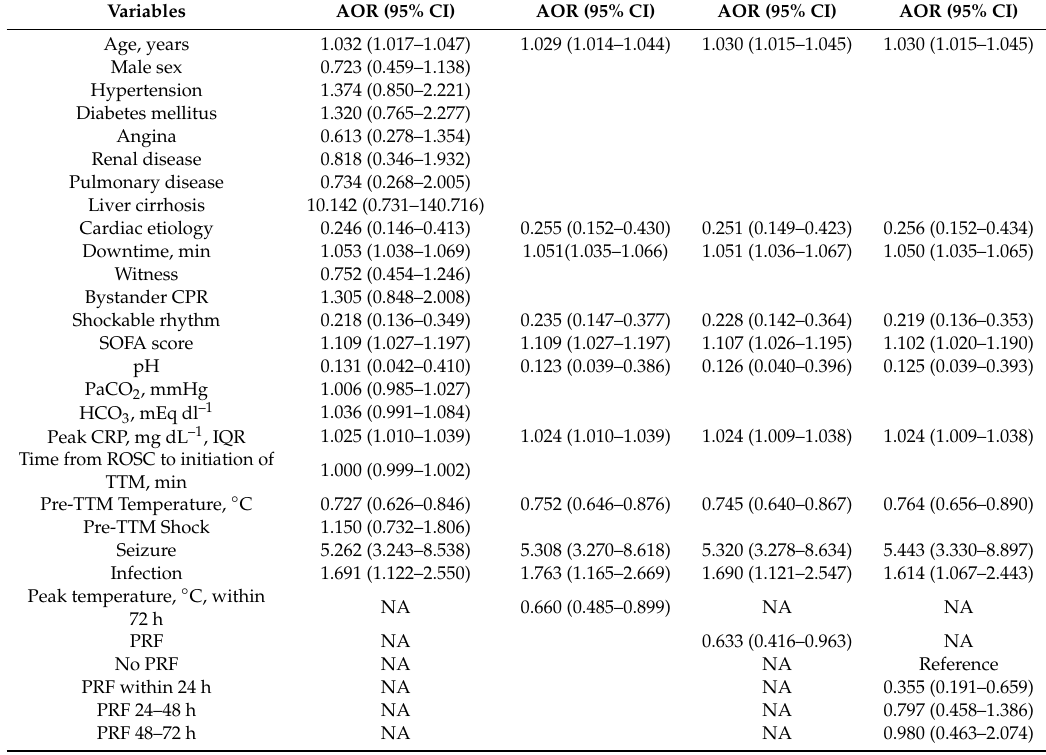
Table 4. Multivariate logistic regression analyses of post-rewarming fever and onset-time of post-rewarming fever for unfavorable neurologic outcome at 6 months after cardiac arrest.